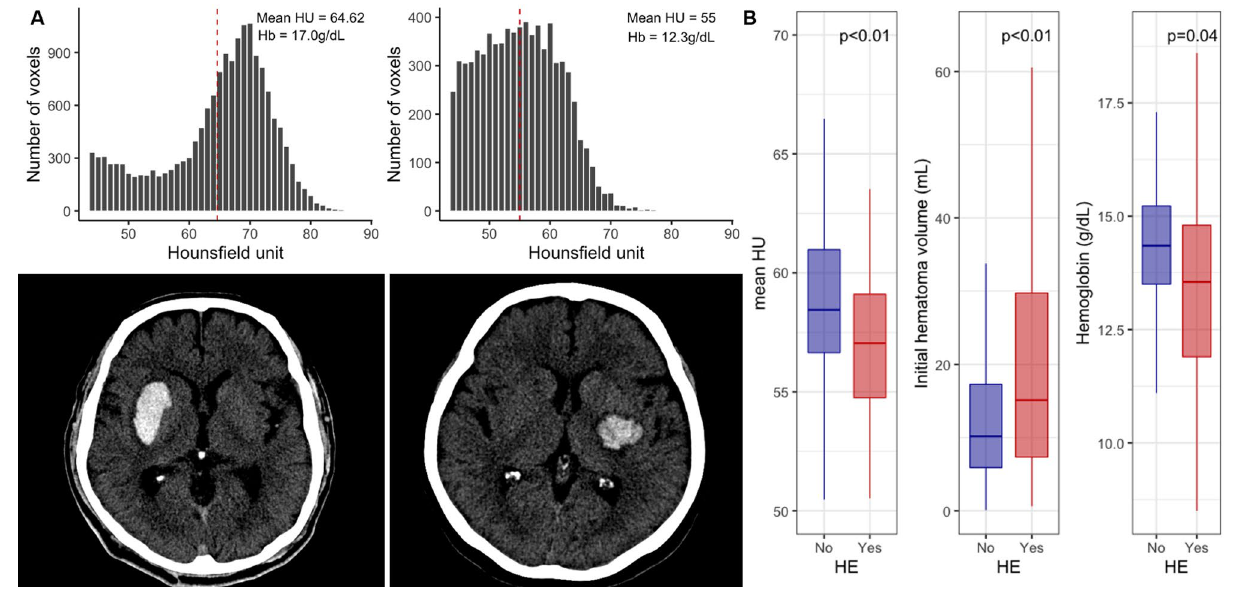
Figure 2. Representative cases and difference in mean HU, hematoma volume, hemoglobin according to hematoma expansion. ( A ) Two representative cases with hematoma expansion (HE) (left) and without HE (right). ( B ) Association among the mean Hounsfield unit, baseline hematoma volume, and hemoglobin with HE. HU, Hounsfield unit; Hb,